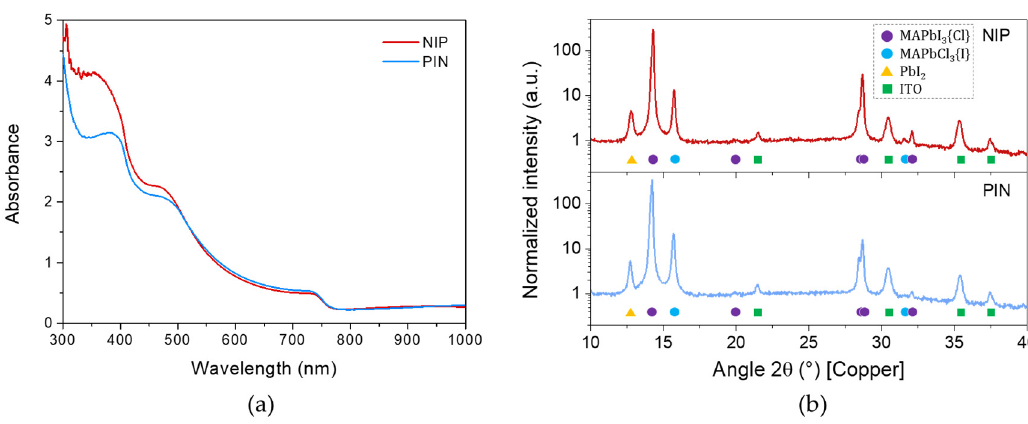
Figure 2. ( a ) Absorbance spectra and ( b ) XRD patterns of the half-cells in the NIP- and PIN-type architectures, i.e., only composed of the perovskite layers grown on np-SnO 2 (dark red) and on poly-triarylamine polymer (PTAA) (light blue), respectively.